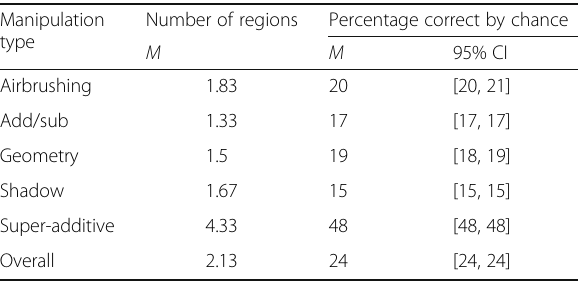
[24, 24] CI confidence interval. For each manipulation type, we show the mean number of regions that contained the manipulation across all six images. The manipulation type “ Overall ” is the mean number of manipulated regions across all six images and all five manipulation types. To determine chance performance in the location task, we ran a Monte Carlo simulation of one million responses based on the number of regions manipulated for each image and manipulation